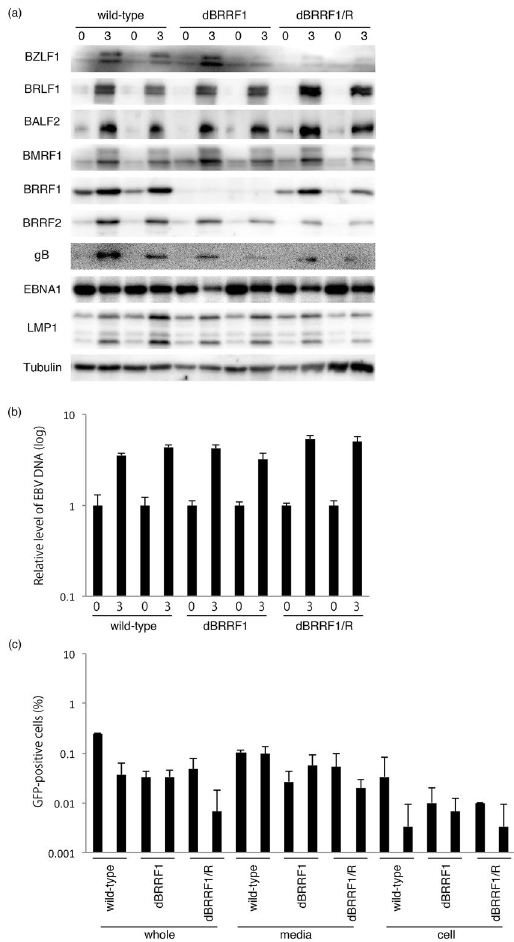
Figure 4. Lytic protein expression, EBV DNA synthesis and progeny production in wild-type, dBRRF1 and dBRRF1/R viruses after forced expression of BRLF1. ( a ) HEK293 cells harboring the EBV BAC were transfected with the BRLF1 expression vector. Cells were collected on days 0 and 3 and subjected to immunoblotting. The original blots are presented in Supplementary Figures 14 and 15. ( b ) DNA from cells collected on days 0 and 3 was used for qPCR. Each bar represents the mean and standard deviation of three independent experiments. ( c ) Viruses were collected from the media (media), cells (cell) or both (whole) on day 4. After a freeze-thaw process and centrifugation, the supernatants were cultured with Akata(-) cells. GFP-positive cells, representing progeny virus titres, were counted using FACS. Each bar represents the mean and standard deviation of three independent